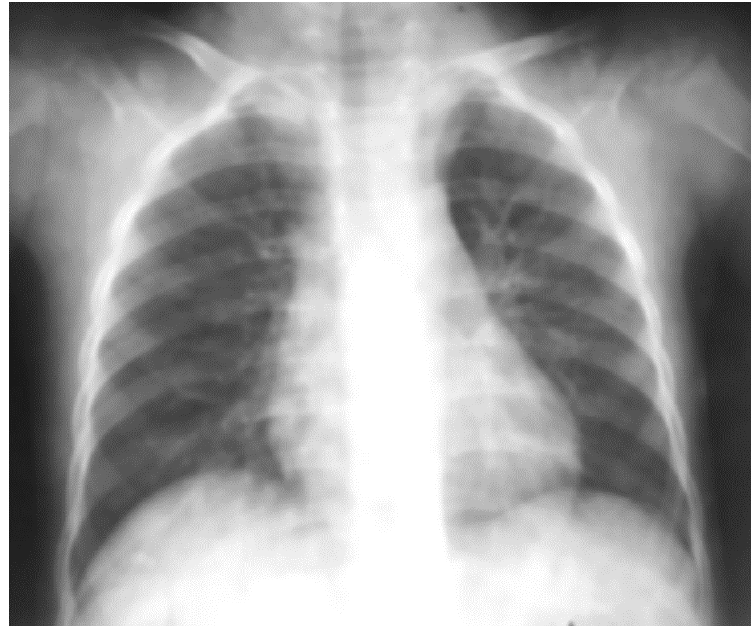
Figure 9. Correspondent CXR, no opacities.